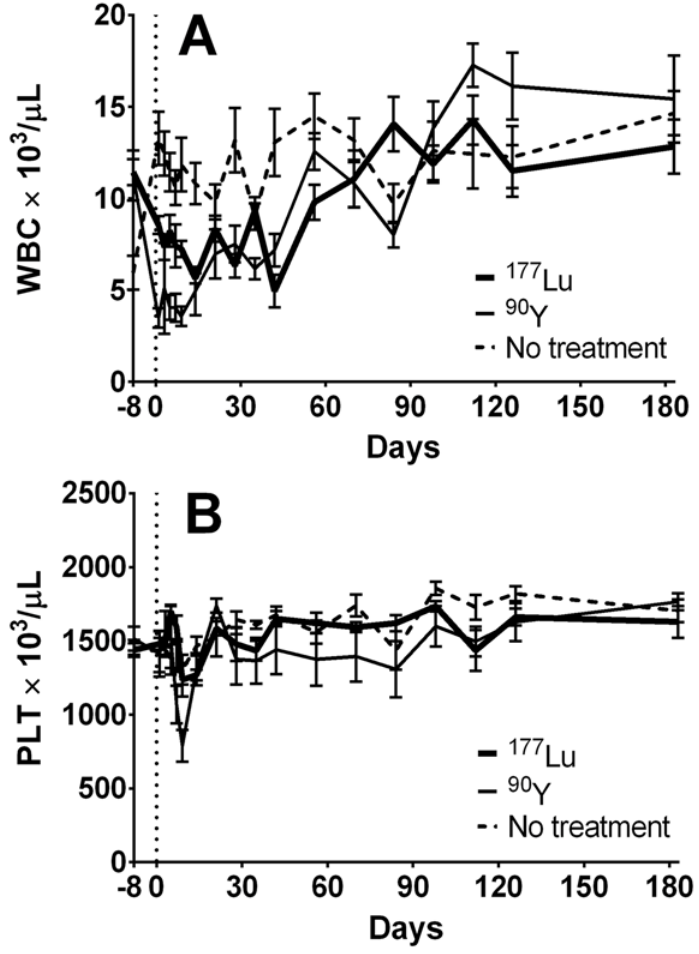
Fig 5. Radiation-induced toxicity in non-xenografted mice after treatment with 37 MBq of 177 Lu- or 90 Y- PRIT. 1F5-SA (300 μ g) was co-injected with 400 μ g of HB8181, followed 20 hours later by 50 μ g of NAGB. Four hours later, 37 MBq of either 177 Lu- or 90 Y-labeled DOTA-biotin was administered. The control group received no injections. (WBC (A) and PLT (B) counts ± SD; n =